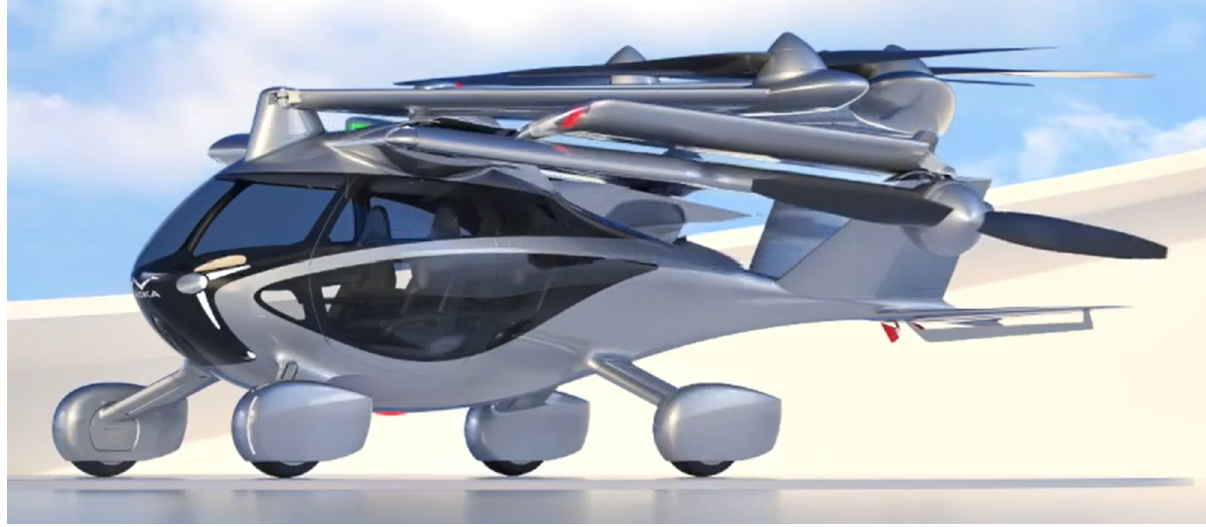
Figure 10: An imagined view of the ASKA ™ fl ying car with the wing and propeller - carrying arms folded ( image credit: NFT Inc., used with permission ) .